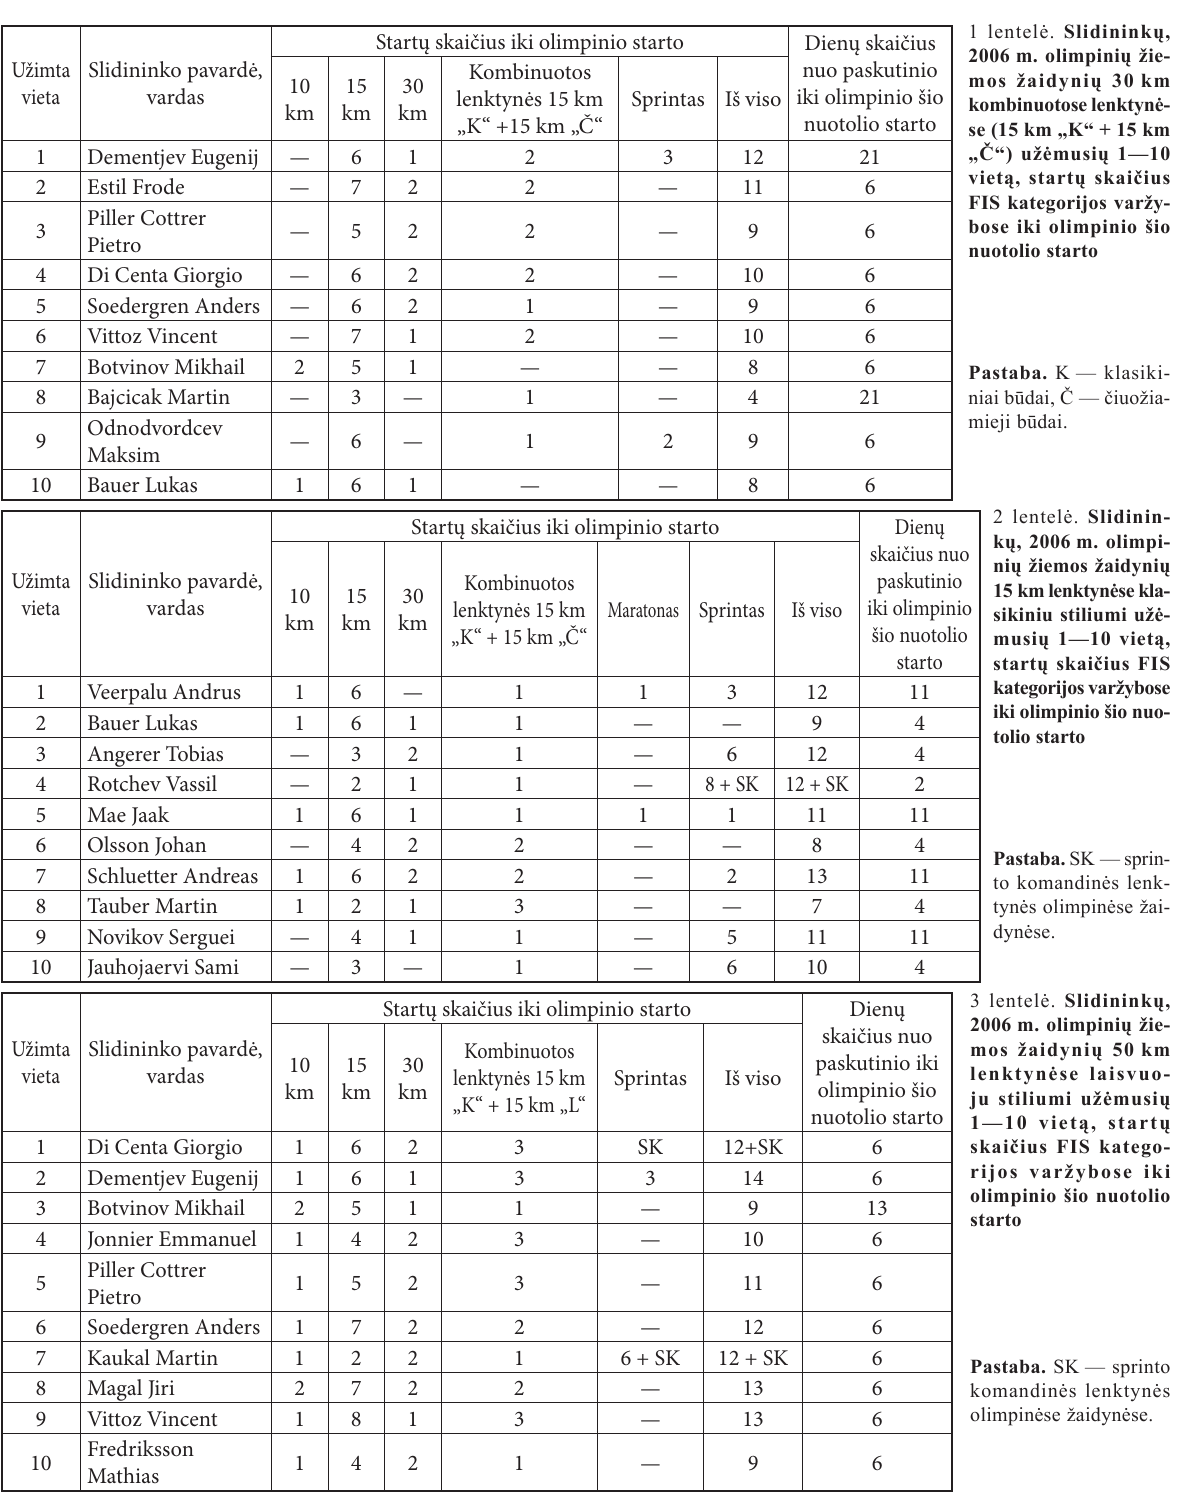
po paskutinio starto oficialiose FIS kategorijos varžybose iki olimpinio starto tur ė jo 11 dien